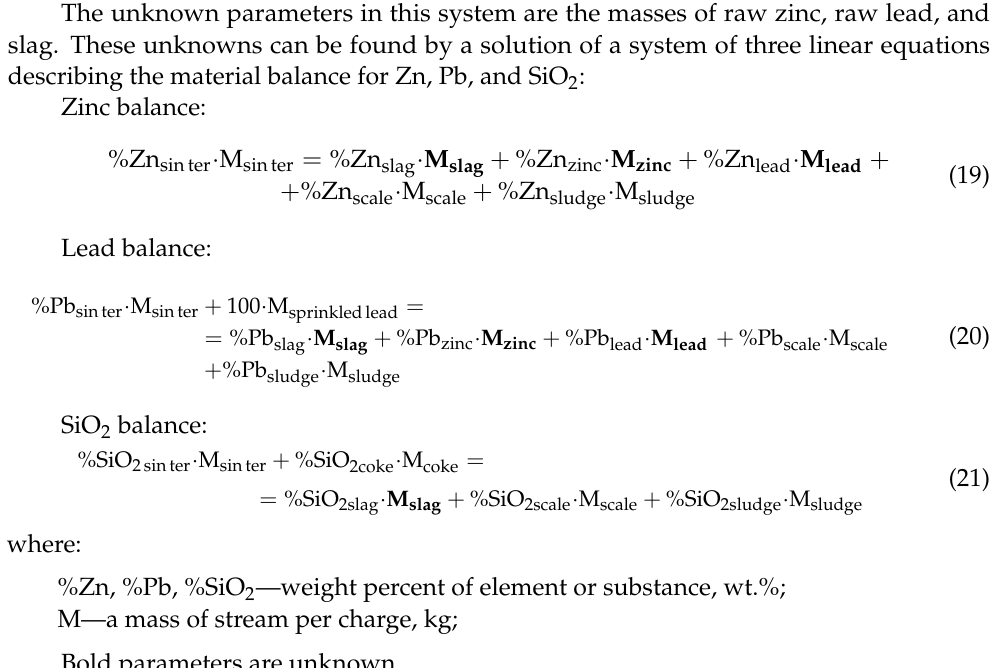
Figure 7. Material streams in an ISF.